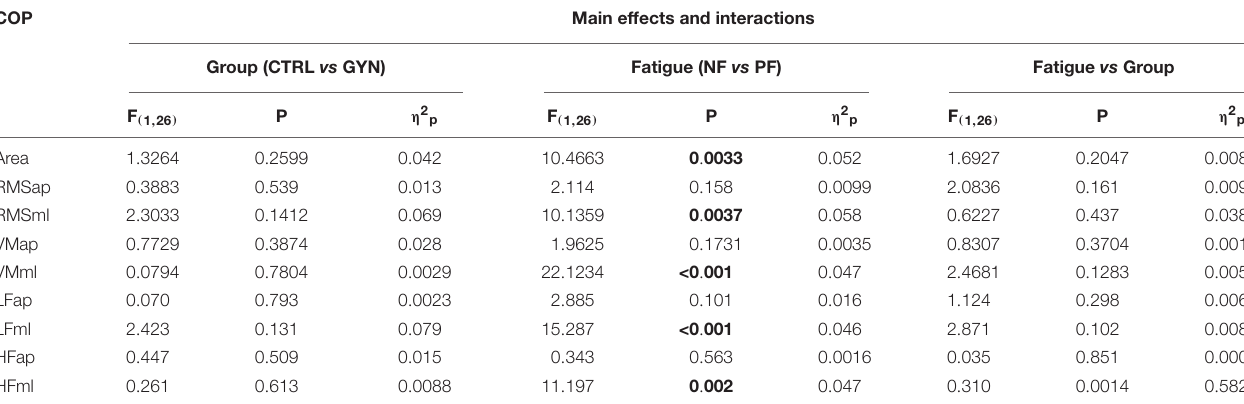
TABLE 2 | Statistical results of the two-way analysis of variance (ANOVA) applied to the center of pressure (COP) parameters before and after the fatiguing protocol. COP Main effects and interactions Group (CTRL vs GYN) Fatigue (NF vs PF) Fatigue vs